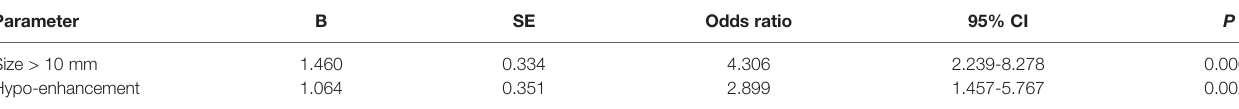
TABLE 3 | Multivariate logistic regression analysis of association of CLNMs and US characteristics in PTC patients with Hashimoto ’ s thyroiditis. Parameter B SE Odds